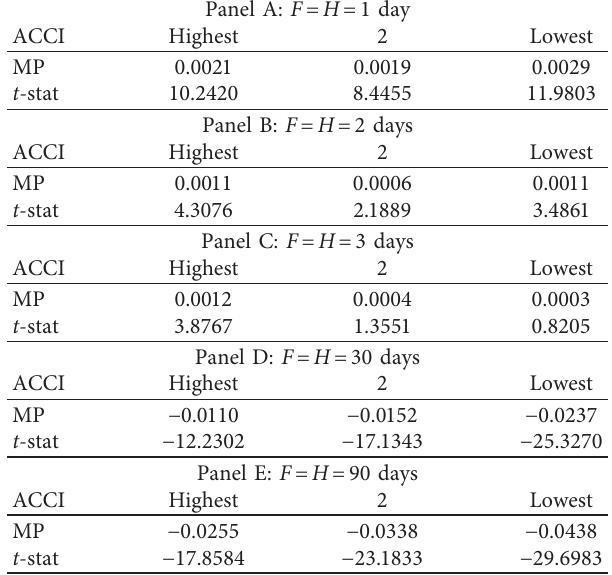
Table 8: The effect of the daily relative order imbalance: three groups.